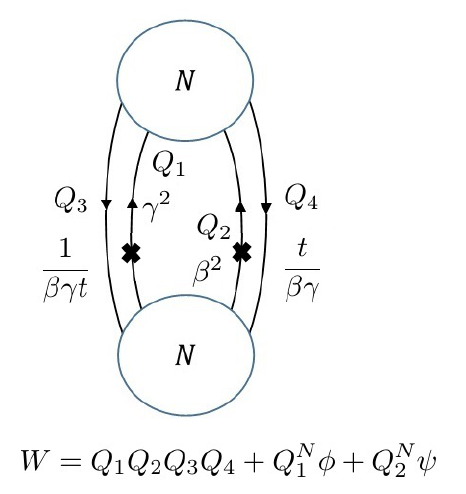
Figure 5 . The quiver diagram for the 4d class S ( 1 ; 1 ; 0). Next to the (cid:12)elds are their charges summarized through fugacities. The theory has a 2 2